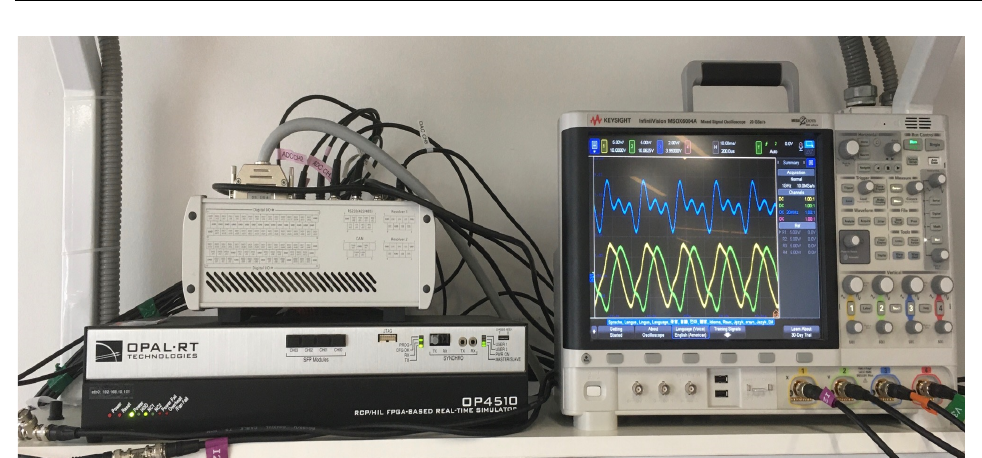
Figure 3. Real-time